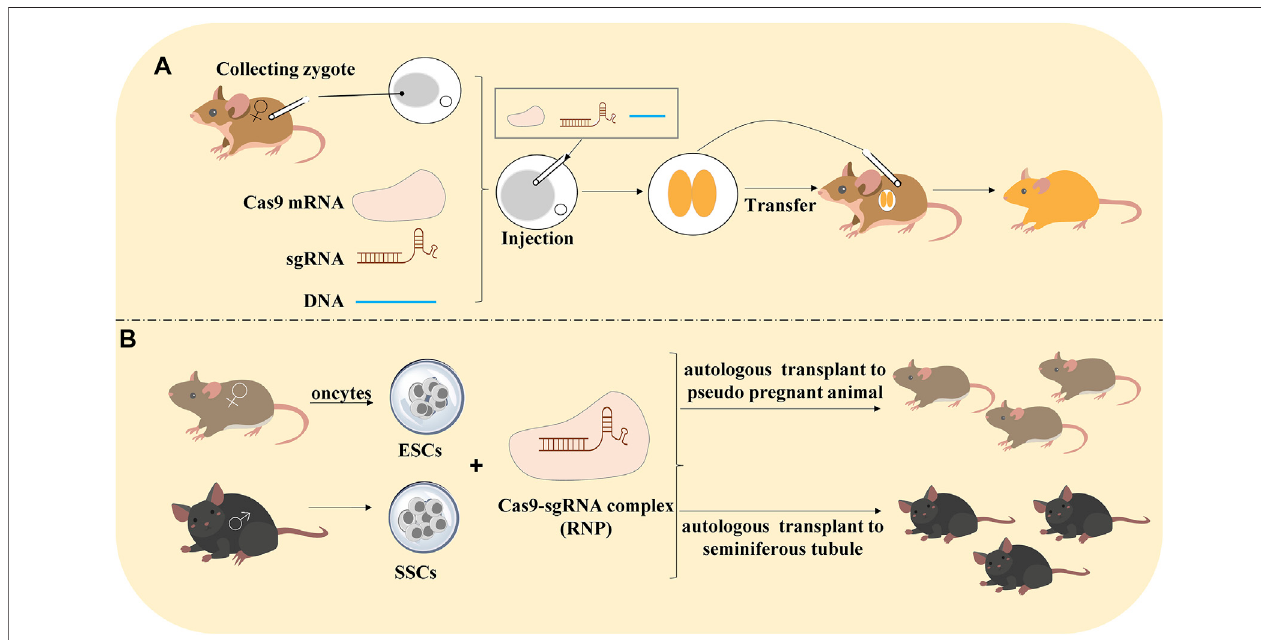
FIGURE 2 | Methods of CRISPR/Cas9 technology to construct animal models. (A) Editing gene in embryos. Collecting the zygote that was injected with Cas9 mRNA, sgRNA, and DNA. After the zygote develops into an embryo, it would be transferred into the animals to produce generation. (B) Editing gene in haploid ESCs and SSCs: haploid embryonic stem cells (ESCs) are pluripotent cells generated from oocytes. CRISPR/Cas9-mediated gene editing in ESCs and autologous transplant to pseudo-pregnant animals to produce generation. Spermatogonia stem cells (SSCs) would be transfected by RNP and autologous transplant to seminiferous tubule to produce the